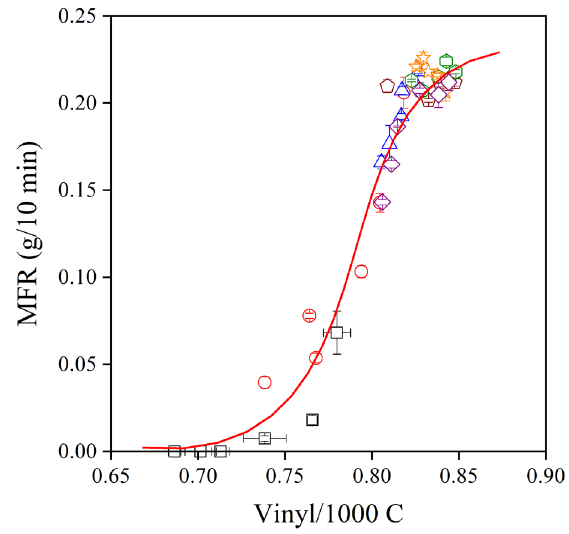
Figure 10. Correlation between the vinyl group content and melt flow rate of polyethylene containing different additive packages. Symbols are the same as in Figure 6.